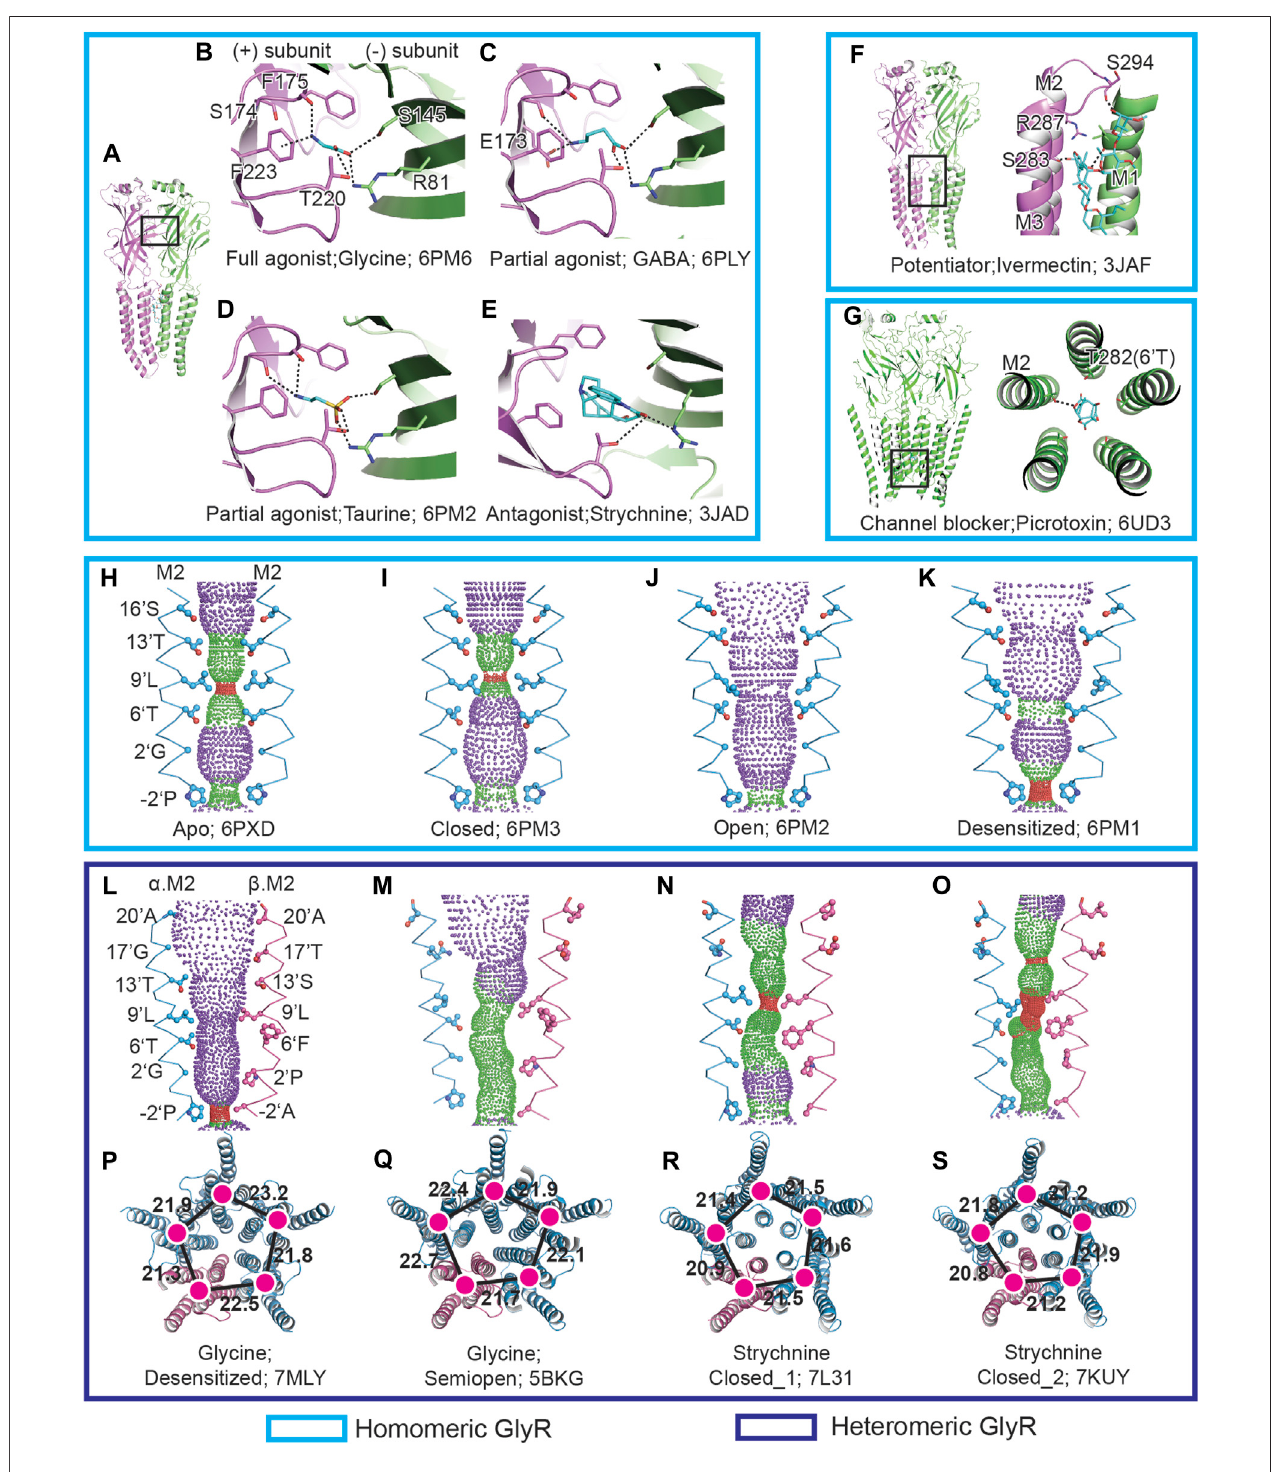
FIGURE 1 | GlyR – ligand interactions and the ion channel permeation pathway. (A) , Side view of isolated homomeric GlyR dimer in cartoon representation. The principle (+) and complementary ( − ) subunit are colored in pink and green, respectively. The boxed area is enlarged in (B – E) . (B – E) Views of binding pockets of homomericGlyRbound with glycine (B) ,GABA (C) ,taurine (D) , and strychnine (E) .Theligand molecules areshown in stickrepresentationswithoxygen inred,nitrogen in blue, and carbon in cyan. The possible hydrogen bonds are shown asdashed lines. (F,G) Views ofivermectin (F) and picrotoxin (G) binding tohomomericGlyR. (H – K) ShapeandsizeofthehomomericGlyRionpermeationpathwayforapo (H) ,closed (I) ,open (J) ,anddesensitized (K) state.M2helicesareshownascartoonsand thesidechainsofpore-liningresiduesareinballandstickrepresentation.Purple,green,andredspheresde fi neradiiof > 3.3 Å,1.8 – 3.3 Åand < 1.8 Å,respectively. (L – O)